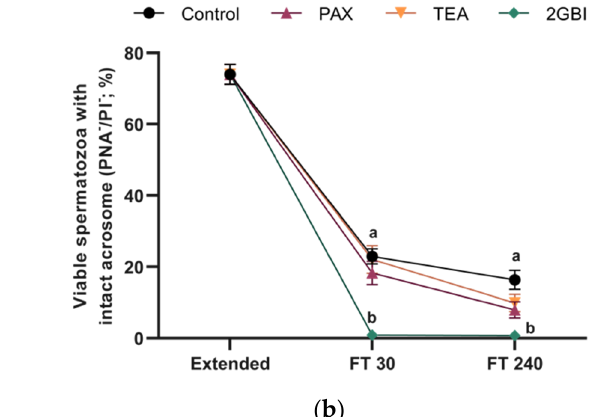
Figure 3. Curvilinear velocity (VCL; a,b ) and straight-line velocity (VSL; c,d ) in extended and frozen–thawed (FT) samples at 30 min and 240 min post-thaw. In Experiment 1 ( n = 8), TEA, PAX, and 2-GBI blockers were added to LEY medium at 15 °C ( a,c ), whereas in Experiment 2 ( n = 9), they were added to LEYGO medium at 5 °C ( b,d ). Different superscripts indicate significant differences ( P < 0.05) between samples within the same time point. Results are given as mean ± SEM.